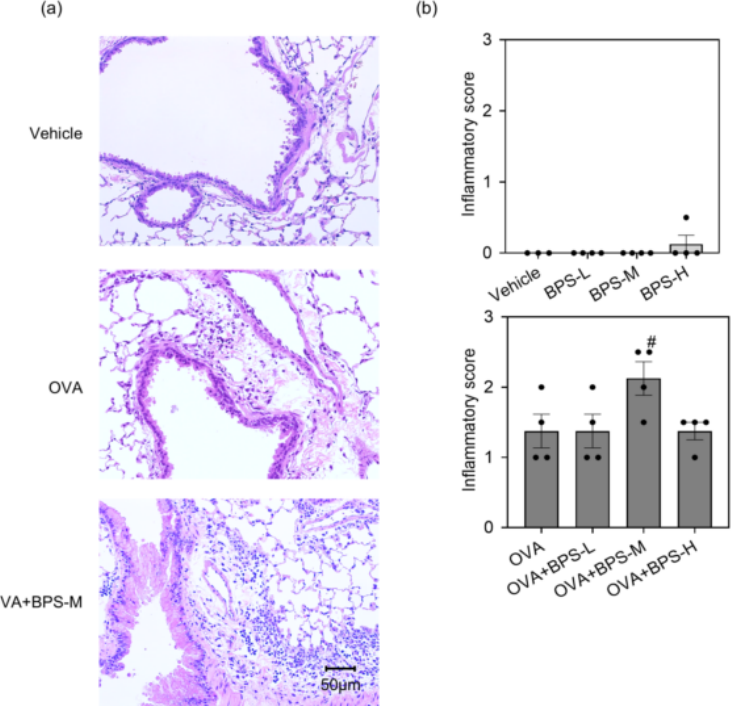
Figure 3. Histopathological findings in the lung. Histopathological changes were evaluated using hematoxylin and eosin staining 48 h after the final intratracheal administration. ( a ) Histopathological images. ( b ) Inflammatory score. Data are expressed as mean ± SE for 3–4 animals per group. # p < 0.05 vs. OVA group. OVA, ovalbumin; SE, standard error.